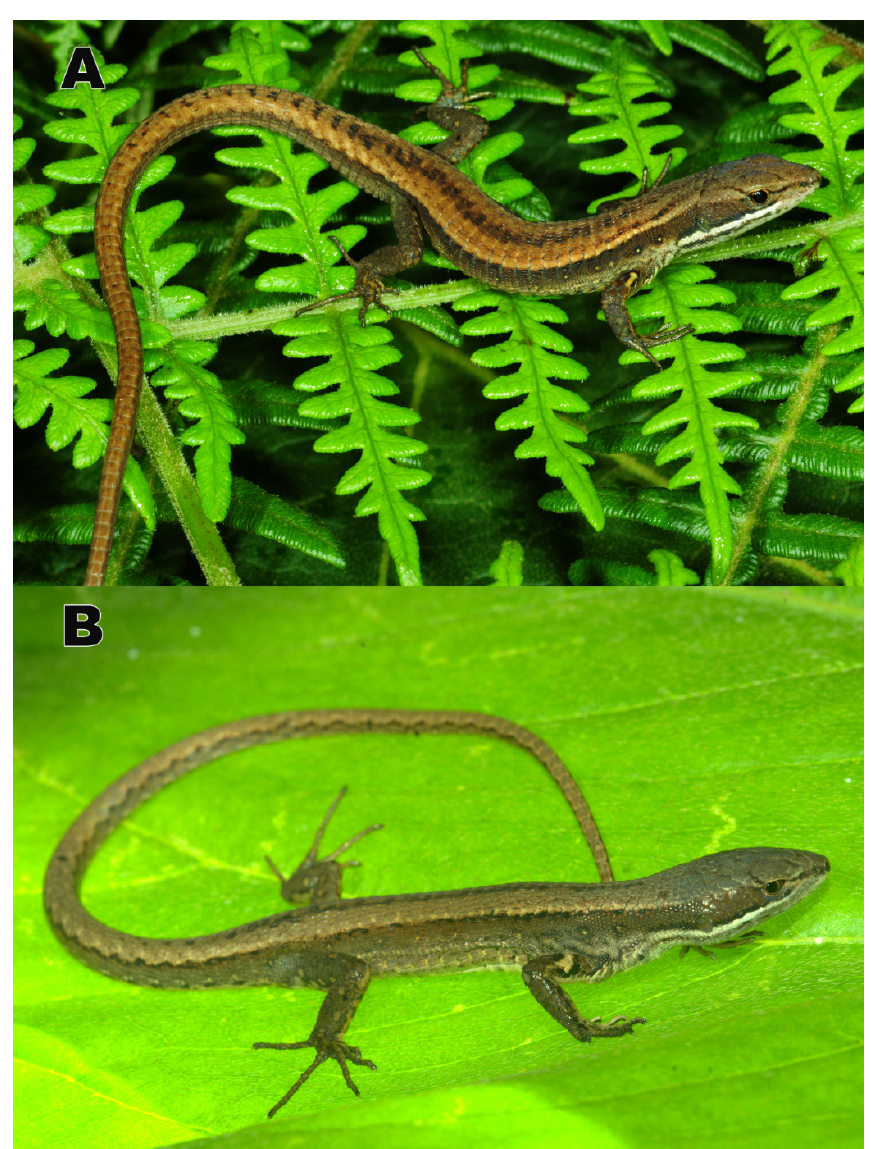
Figure 9. Live specimen of “ Cercosaura manicata boliviana ”; ( A ) adult male CORBIDI 16500 (SVL = 42.5 mm), from near San Pedro, Kosñipata Valley, Department of Cusco, Peru; ( B ) CORBIDI 18716 (SVL = 44.1 mm), from Santo Domingo, District of Limbani, Province of Sandia, Department of Puno, Peru. Photo: Alessandro Catenazzi.